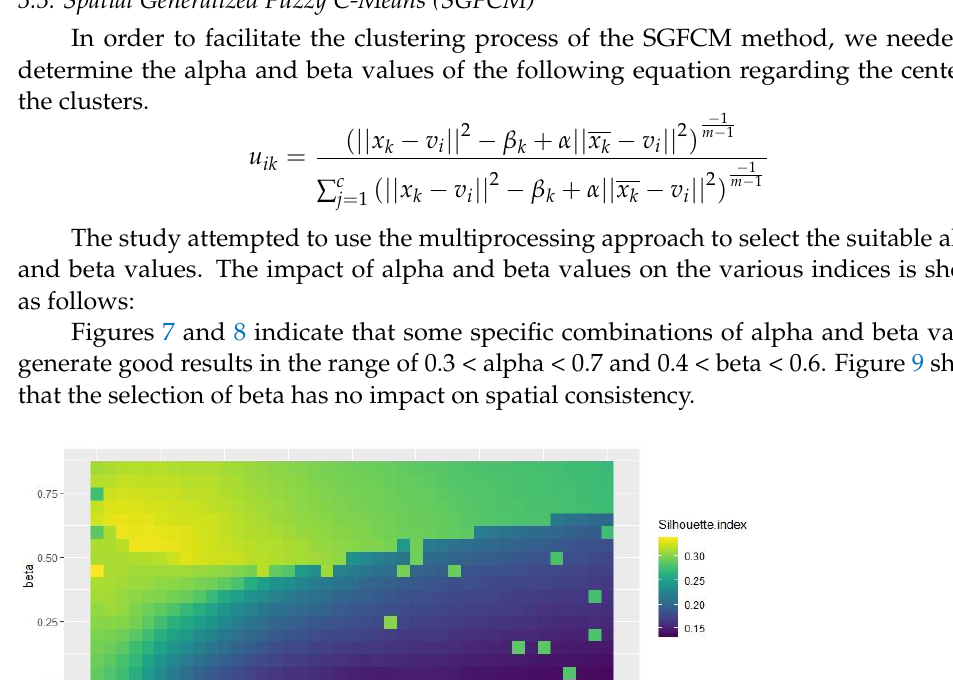
Figure 6. Link between alpha value and silhouette index.